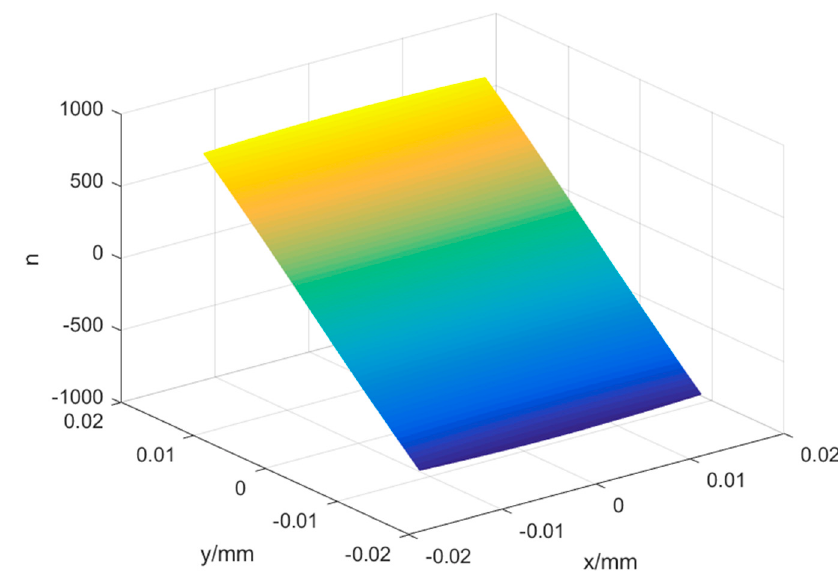
Figure 2. The number of grating lines of the aberrated off-axis Fresnel zone plate.